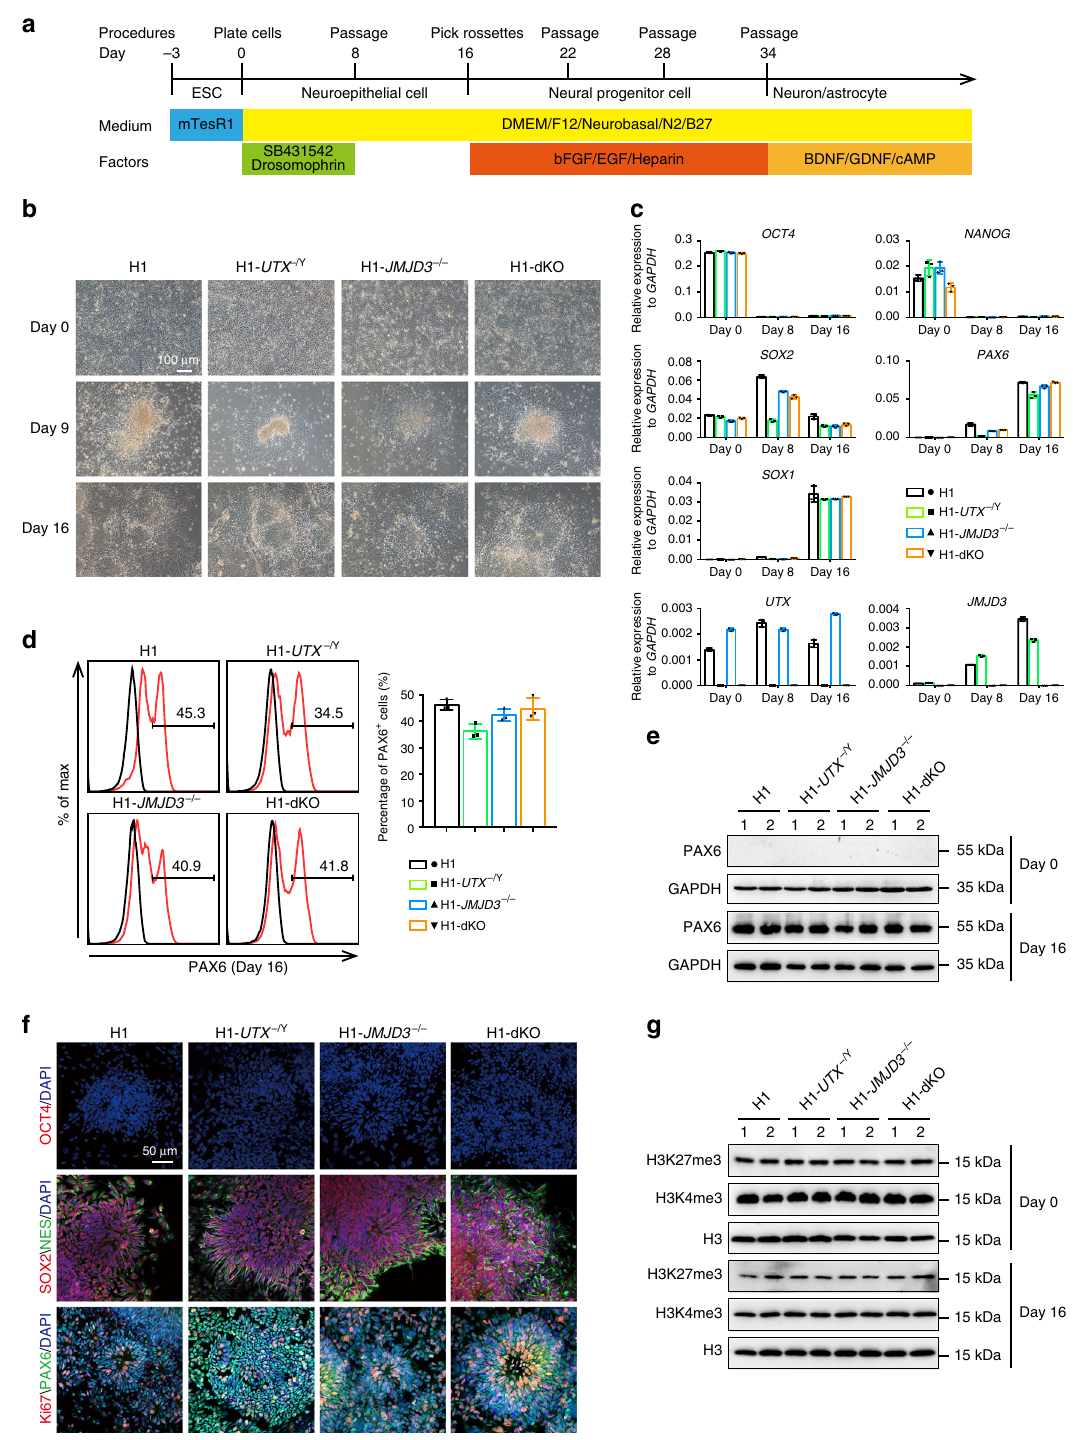
cycle genes were signi fi cantly reduced in H1-dKO NPCs (Fig. 2j). Together, these data indicate that the KDM6s JMJD3 and UTX are essential for long-term self-renewal and pro- liferation in human NPCs. KDM6s-de fi cient NPCs fail to generate neurons and astrocytes . To further characterize the potential of the three KDM6 mutant NPC lines lacking UTX and/or JMJD3, we performed sponta- neous differentiation by withdrawing growth factors that support